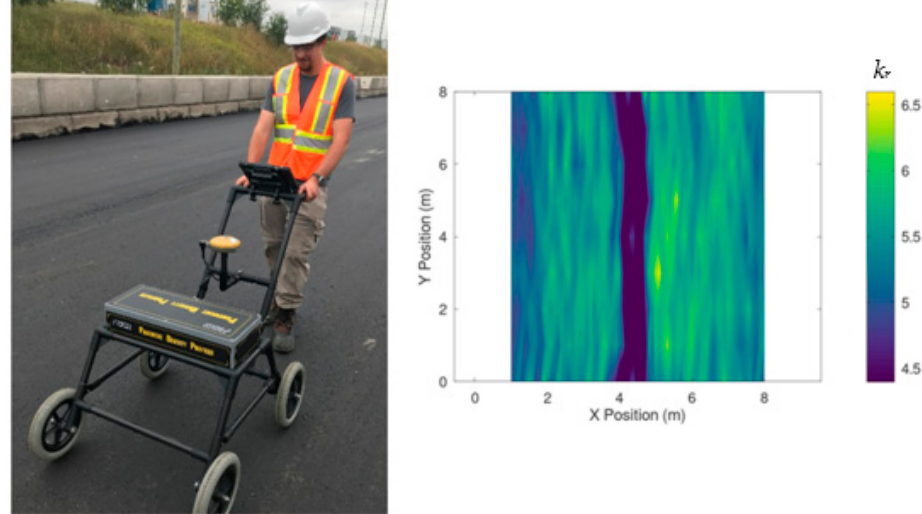
Figure 6. A cart-based PDP ( left ) and a plan map of k r variation in the grid area (right). The darker areas are of low dielectric permittivity and are most prevalent along the joint between the two lanes ( right ).